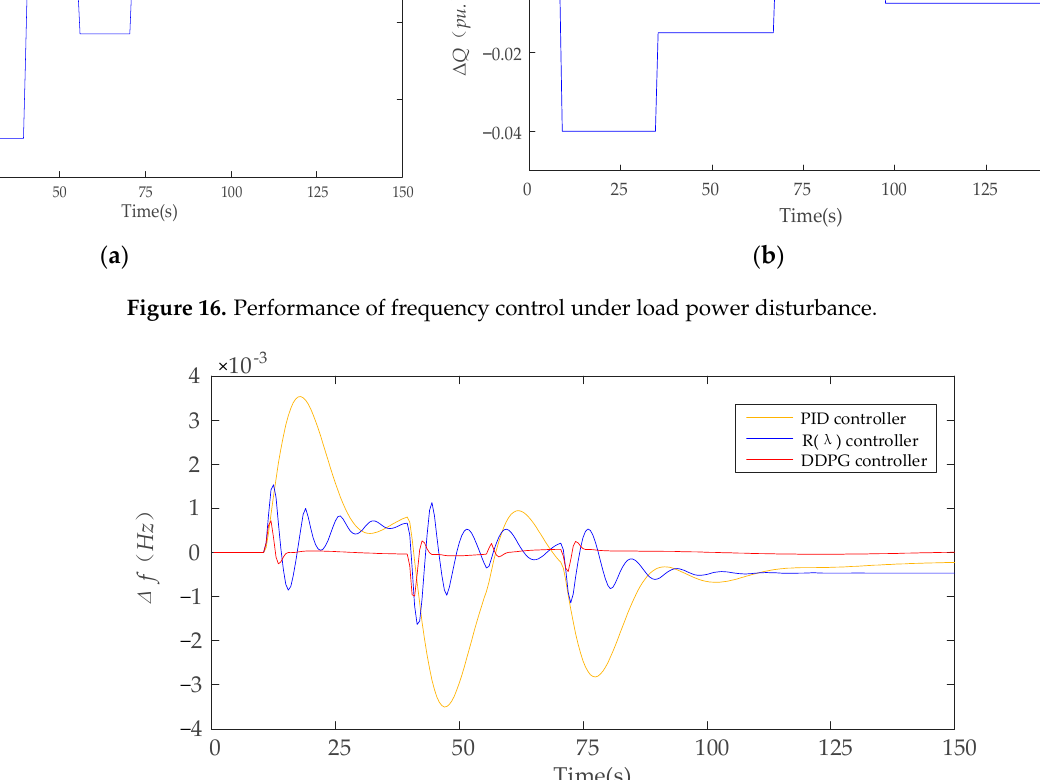
Figure 16. Performance of frequency control under load power disturbance. Δ U PID controller R( λ ) controller DDPG controller Figure 17. Performance of voltage control under load power disturbance.